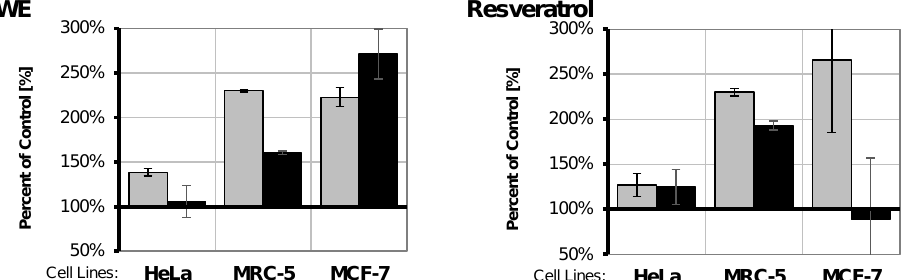
Figure 9. Activation of transcription factor NF-kB in the cells in the culture upon treatment with V. vinifera pruning waste subcritical water extract (SWE) and resveratrol in the concentration of 25 µ g/mL (light gray), or 50 µ g/mL (black) for 48 h. Results expressed as percent of control NF-kB p65 presence in nuclear extracts of HeLa, MRC-5 and MCF-7 cell lines, determined by ELISA p65 assay (Abcam, Cat. No. ab133112). Nuclear extracts obtained by Nuclear Extraction Kit (Abcam, Cat.No. ab113474). Protein concentration determined prior to ELISA NF-kB p65 assay using a BCA Protein Quantification Kit (Abcam, Cat. No. ab102536).